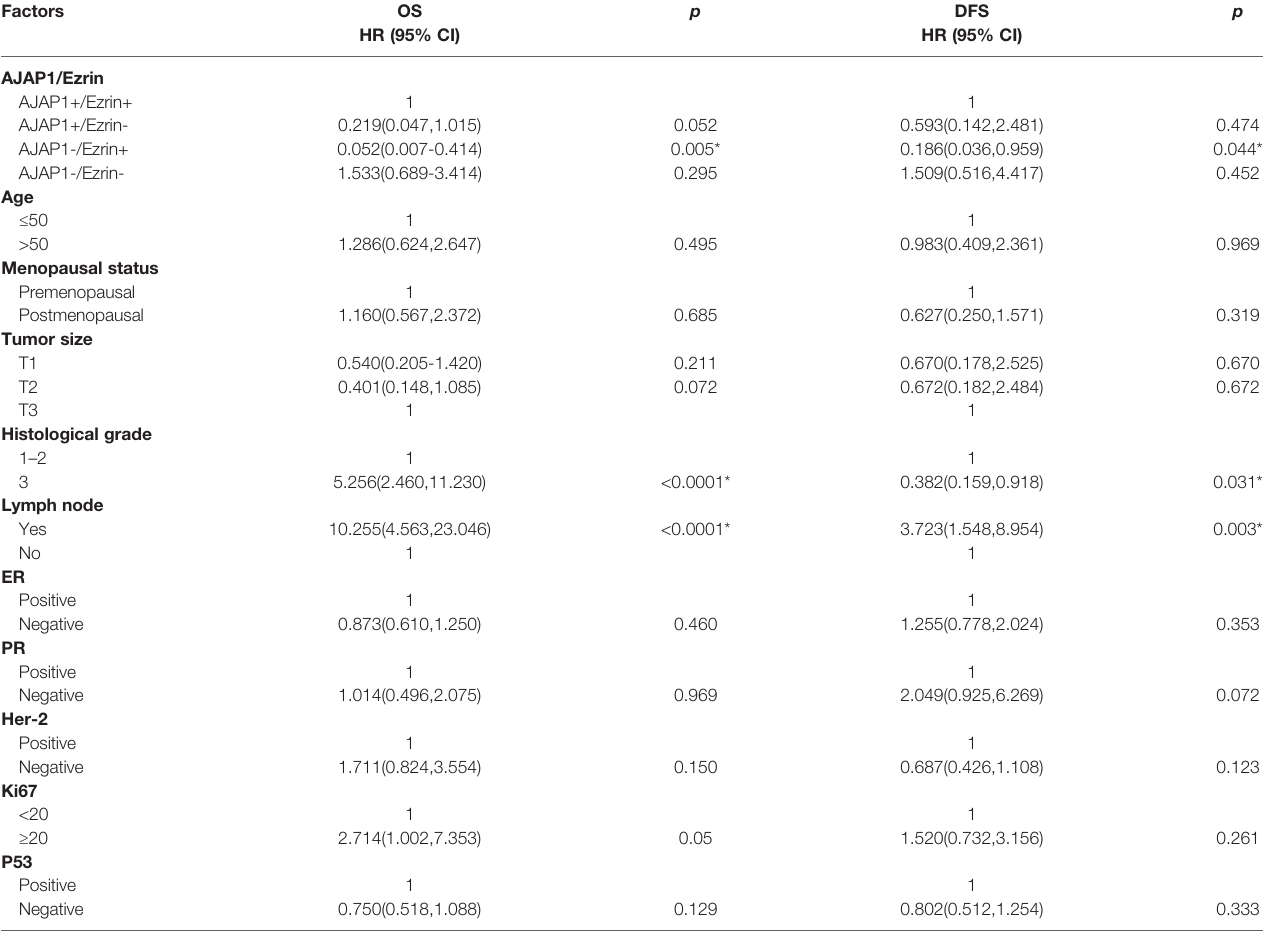
TABLE 3 | Univariate analysis of OS and DFS in breast cancer patients. Factors